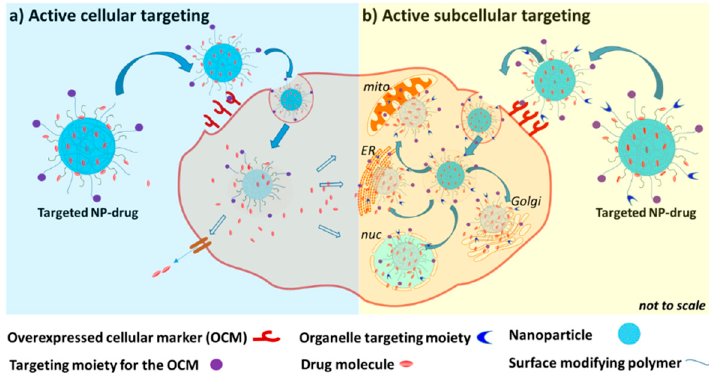
Scheme 1. Schematic illustration showing active cellular (left) and subcellular (right) targeting of NP-drug formulations. ( a ) In active cellular targeting, NP-drug complexes bind to the cell surface via a ffi nity interactions between a targeting moiety (e.g., folic acid) and cell surface markers (e.g., folic acid receptor). The NPs are internalized via endocytosis and the onboard drugs are released to the cytosol and di ff use to the subcellular sites of action (e.g., nucleus). ( b ) In active subcellular targeting, NP-drug systems bind to the cell surface, internalize, and the NP themselves localize to specific intracellular compartments driven by organelle-targeting moieties on the NP surface. In this approach, the drug molecules are actively delivered directly to subcellular locales such as nucleus